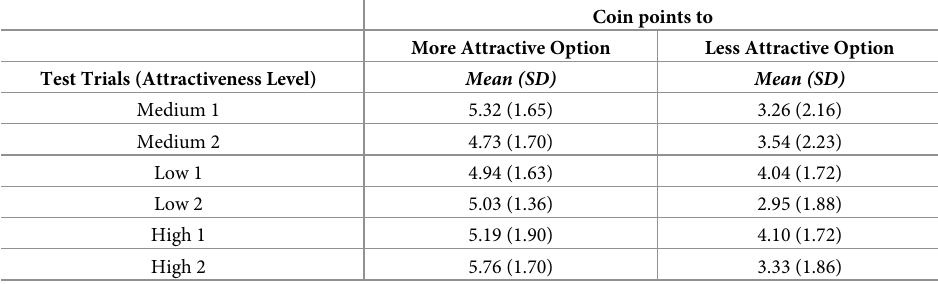
Table 3. Affective reactions (means and standard deviations) in Study 1 depending on whether the coin flip sug- gested the previously more or less attractively rated option.